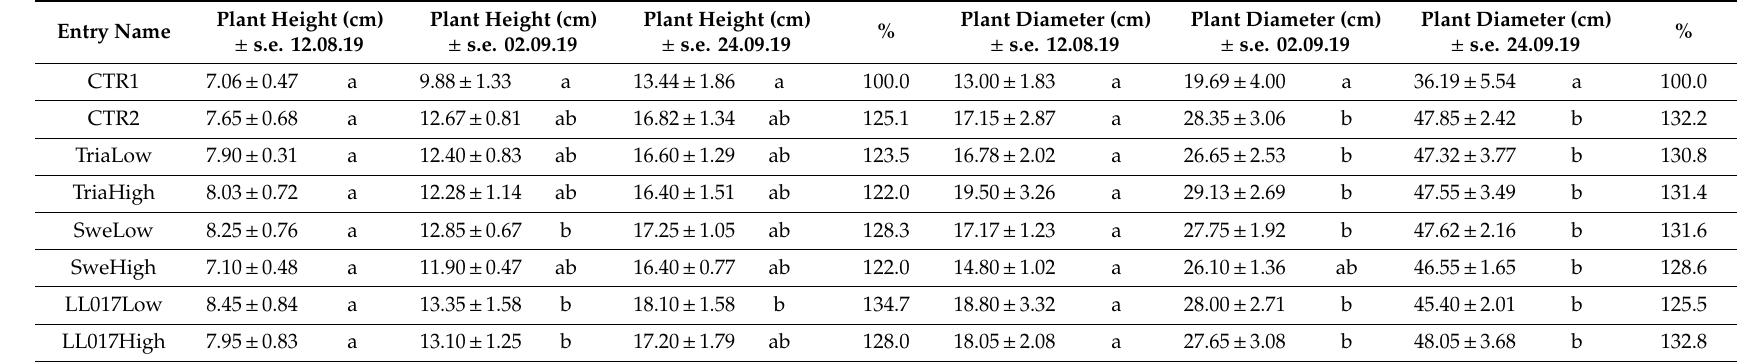
Table 1. Plant dimension assessment. Plant height and diameter were assessed three times during the 2019 growing season. Average values per plot were used for the analysis. The percentage increase for the last assessment (24.09.19) relative to the CTR1 is reported on the right of the respective column. Four and five outlier values were removed for height and diameter, respectively, by using the boxplot function (software Statistica by StatSoft) (coe ffi cient = 1.5) before averaging plot values. The statistical analysis (software Statistica by StatSoft) was performed by means of one-way analysis of variance (one-way ANOVA) with Duncan Test ( α ) = 0.1. For each trait, at least one letter in common indicates no significant di ff erence according to the Duncan